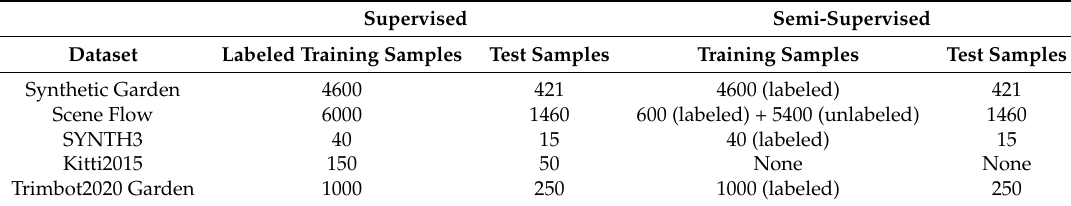
Table 1. A Brief Description of Datasets in This